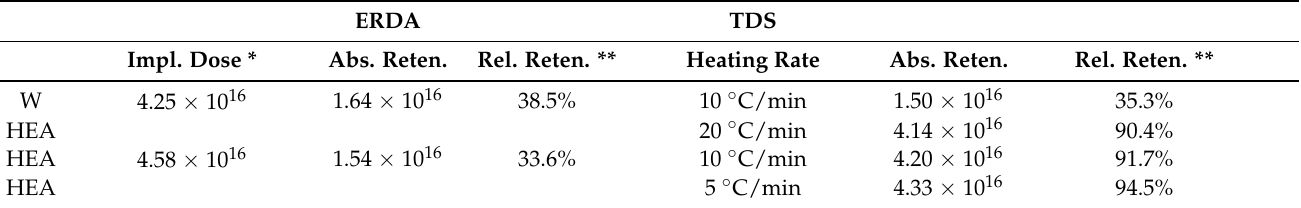
Table 1. Quantities of D measured from WMoTaNbV and W with elastic recoil detection and thermal desorption. * Corrected for backscattering during the implantation, a correction factor was obtained from SRIM. ** Compared with backscattering corrected implanted dose. ERDA TDS Impl. Dose * Abs. Reten. Rel. Reten. ** Heating Rate Abs. Reten. Rel. Reten. ** W 4.25 × 10 16 1.64 × 10 16 38.5% 10 ◦ C/min 1.50 × 10 16 35.3% HEA 20 ◦